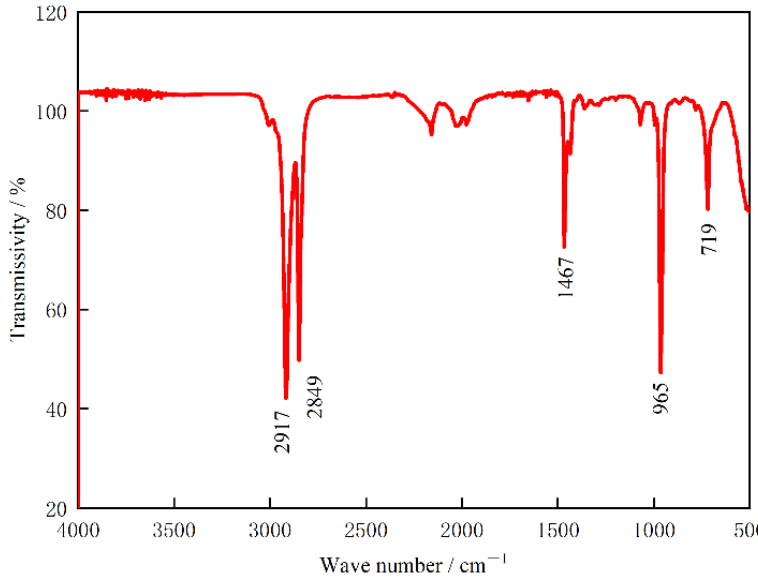
Figure 7. The infrared spectrum diagram of TOR.